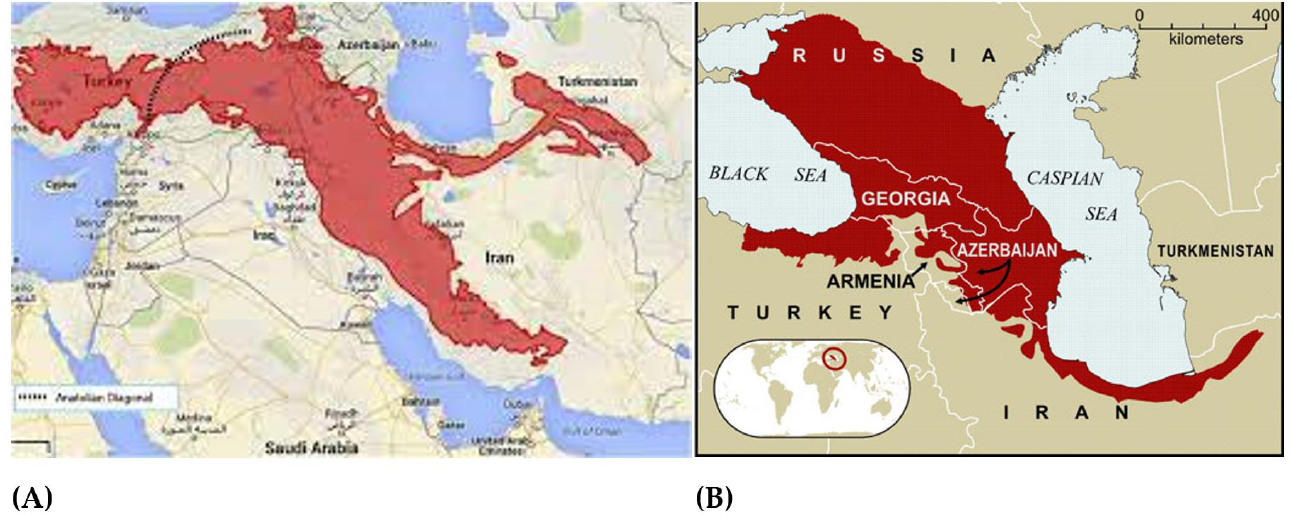
Figure 7. Two biodiversity hotspots regions of Iran (adopted from https://biodiversity.doe.ir/portal/home/?778961/ (accessed on 28 January 2022). Note: ( A ) shows Irano-Anatolian biodiversity hotspot, and ( B ) shows the Caucasus biodiversity hotspot.